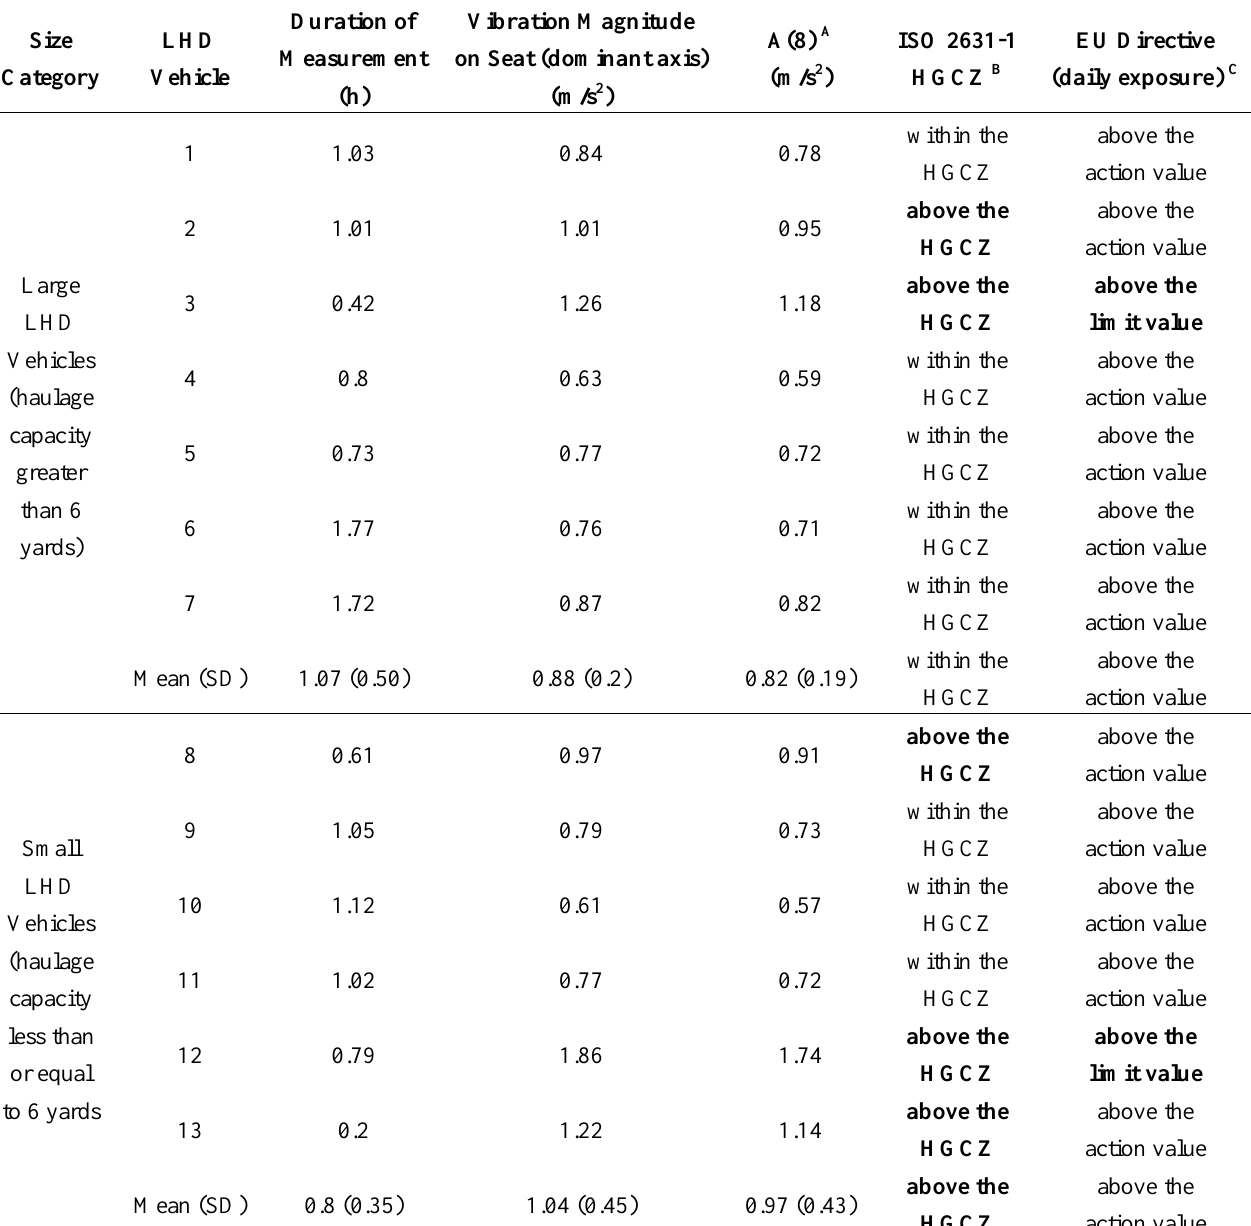
Table 3. Determination of health risk, to the LHD operator, according to ISO 2631-1 HGCZ and European Union Directive daily exposure standards based on the estimated 8-hour equivalent frequency-weighted r.m.s acceleration value,